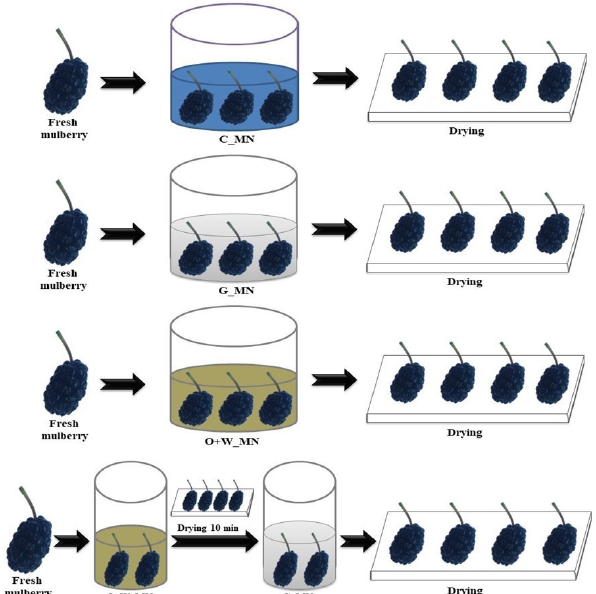
Figure 1. The experimental design for the mulberry fruits with edible coating. C_Mn—control sample, fruits immersed in distilled water; G_Mn—sample with fruits coated with gelatine; O+W_Mn— sample treated with oil and wax ‐ based edible coating; O+W_G_Mn sample subjected to layer ‐ by ‐ layer treatment, the first layer being the oils with wax and the last the gelatine.